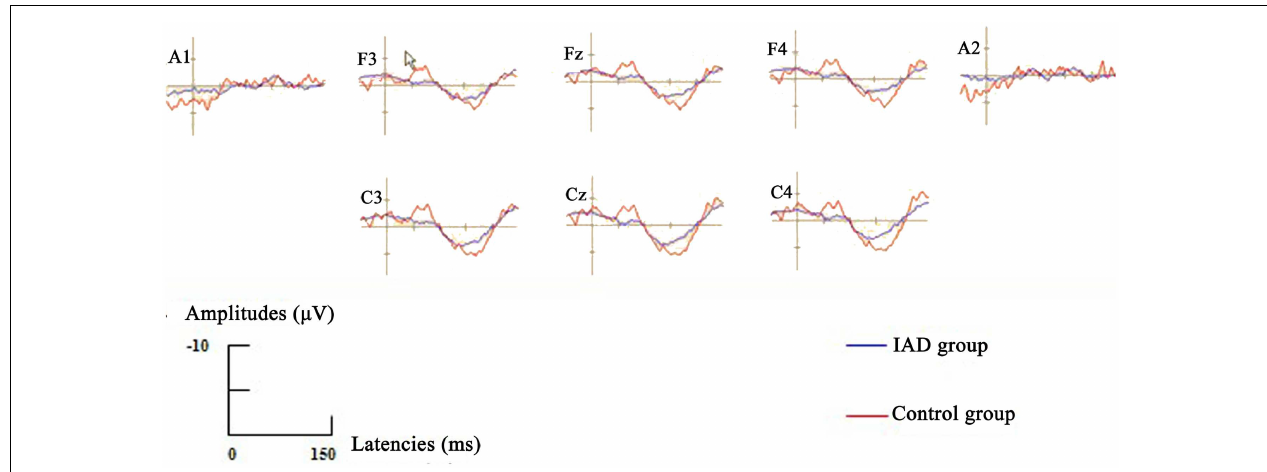
FIGURE 1 | Grand-averaged ERPs waveforms for error (ERN, designated with cursor at F3) were elicited by the modified Erikson flanker task for IAD group (blue lines) and Control group (red lines) .The ERN components were presented within a 50–100ms latency window.